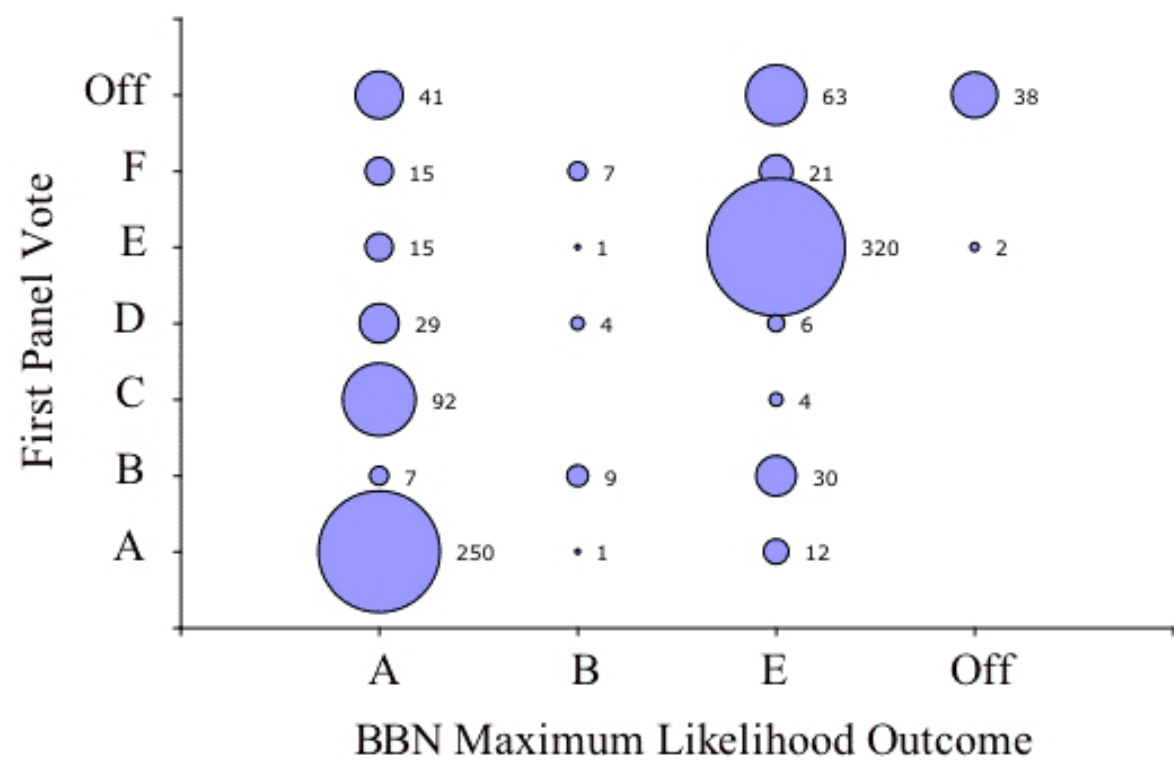
Fig. 9. Distribution of the first round of votes across all species from the 2002 and 2003 evaluation panels of the Annual Species Reviews under the Northwest Forest Plan, by species conservation management category (A-F and Off the list; see Table 1 for category descriptions), for each maximum likelihood outcome of the overall Bayesian belief network (BBN) model (Fig. 1). The area of each bubble corresponds to the number of votes, also shown next to each